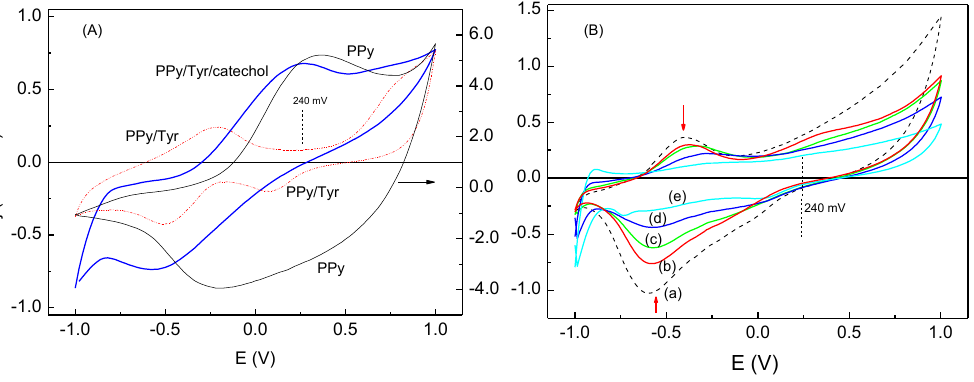
Figure 4. Cyclic voltammograms for: ( A ) PPy ( a ) and PPy/Try ( b ) films in 0.1 mol∙L −1 LiClO without and with 1,0 mmol∙L −1 catechol (PPy/Try/catechol) ( c ); ( B ) PPy/Try films 4 in 0.1 mol∙L −1 phosphate buffer ( a ) and 50 µL of catechol without ( b ) and with 100 µL ( c ); 200 µL ( d ) 300 µL ( e ) of benzoic acid; 50 mV∙s −1